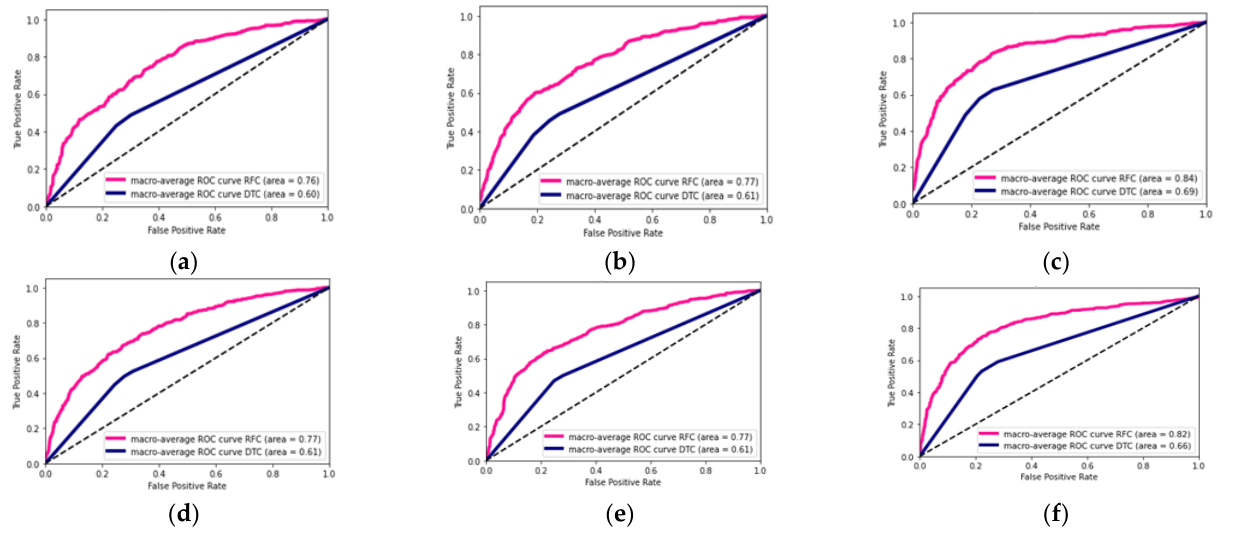
Figure 3. DTC and RFC classification of Healthy, COPD, and Pneumonia for each SVD element and real and imaginary components of the signals: ( a ) ROC curves of real components of SVD U element; ( b ) ROC curves of real component of SVD V T element; ( c ) ROC curves of real component of SVD S element; ( d ) ROC curves of imaginary component of SVD U element; ( e ) ROC curves of imaginary component of SVD V T element; ( f ) ROC curves of imaginary component of SVD S element.